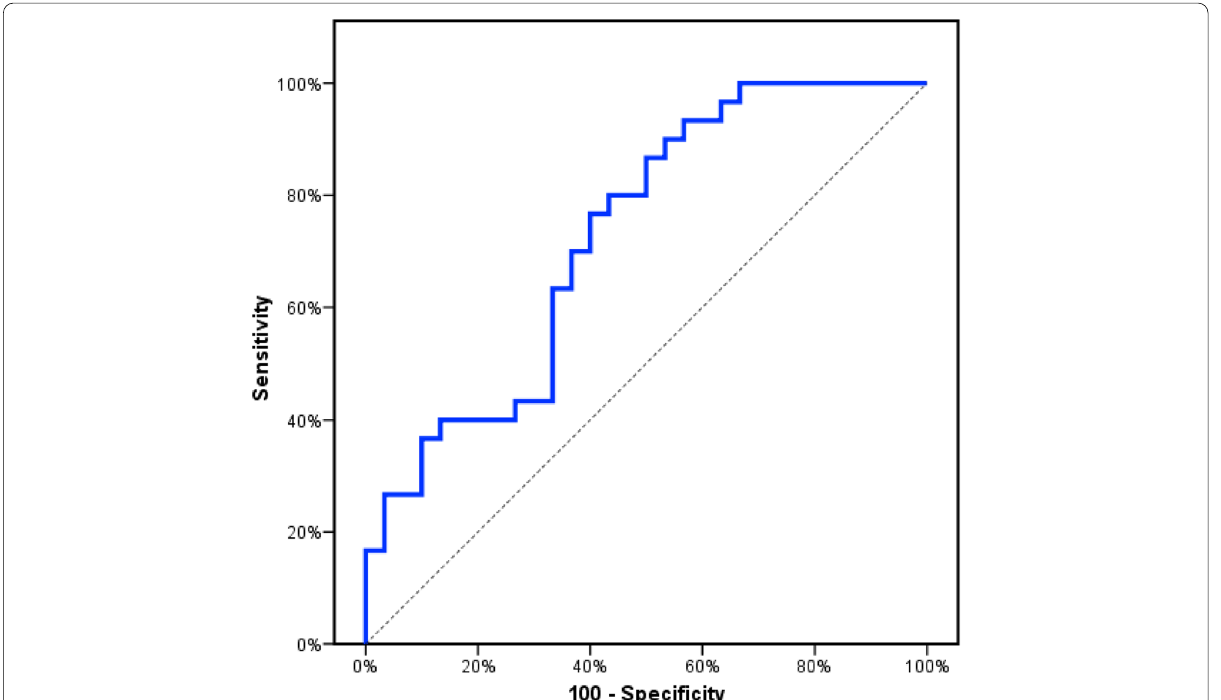
Fig. 5 ROC curve for LTB4 to discriminate compensated cirrhosis patients ( n